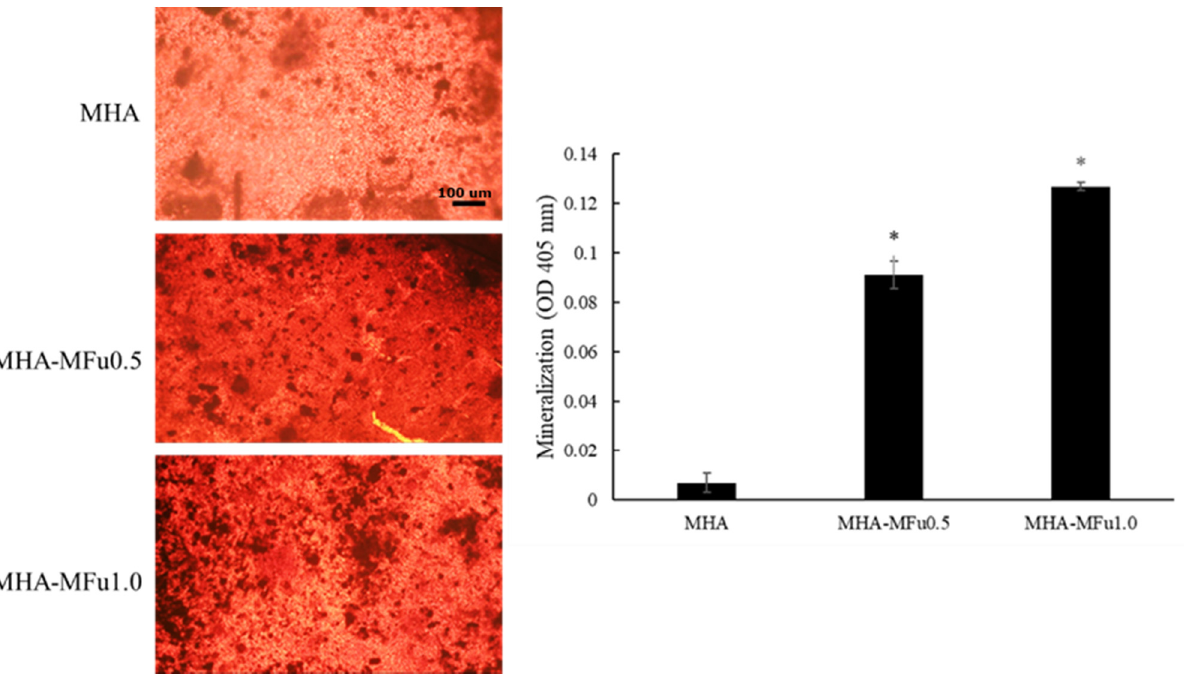
Figure 9. Bone mineralization of MG63 osteoblasts on MHA and MHA-MFu hydrogels after 28 days. * ( p < 0.05) indicates the level of significance. Scale bar = 100 μ m.